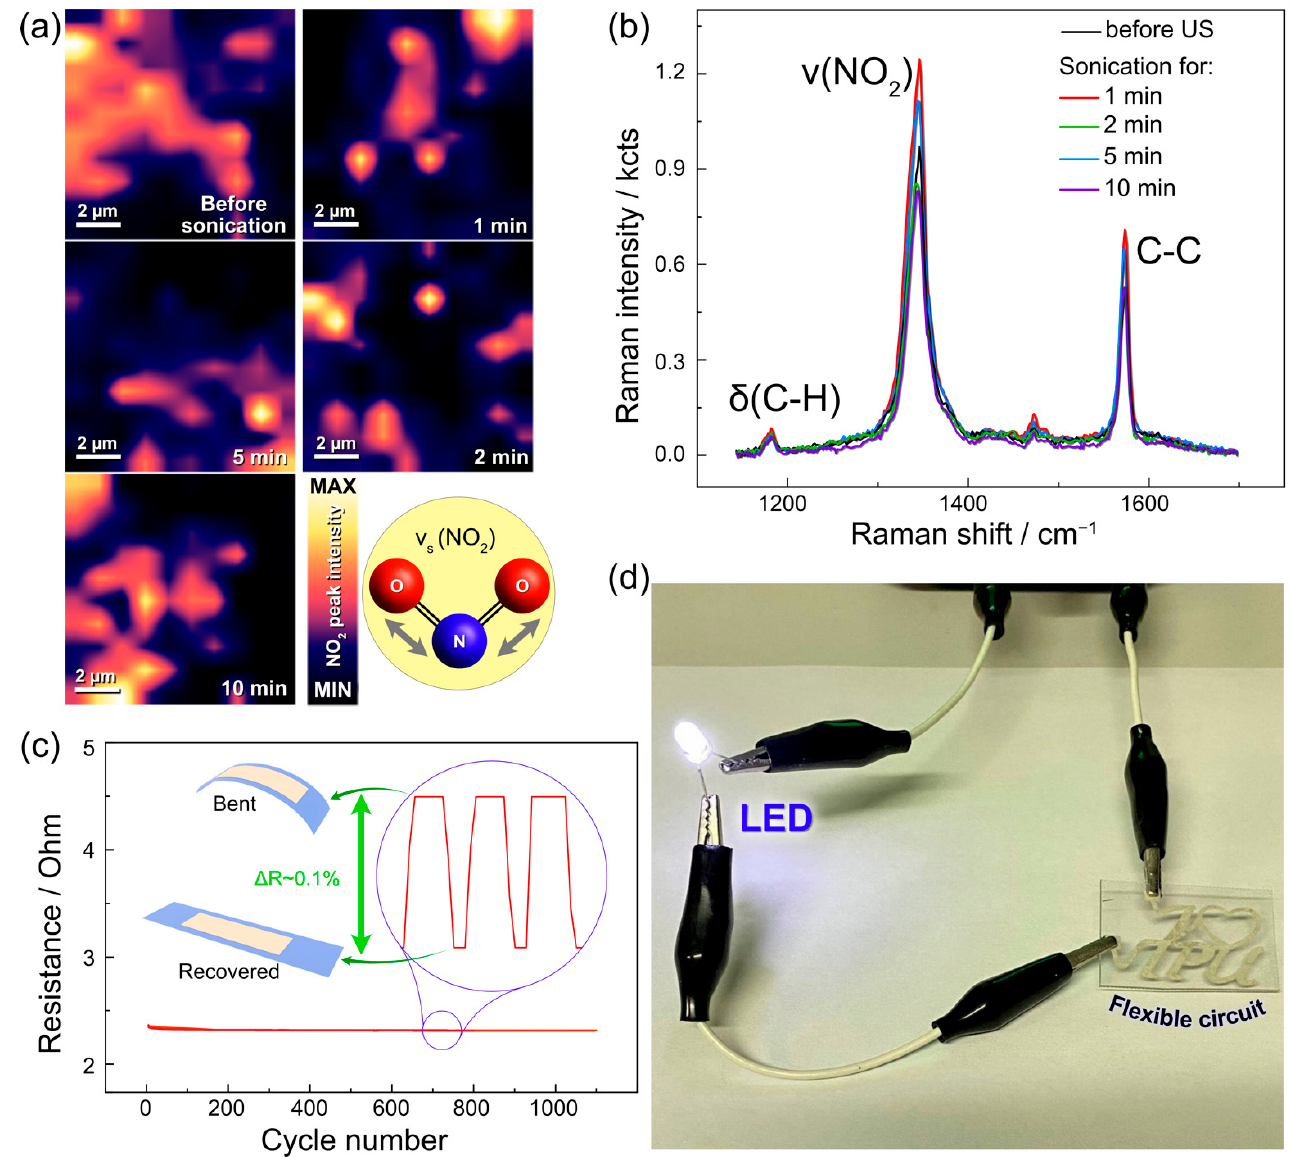
Figure 2. ( a ) The study of reusability and robustness by placing the substrate into the ultrasonic bath for different time periods: 0, 1, 2, 5, and 10 min. The performance was estimated with a Raman map of NO 2 vibrational mode. ( b ) Raman spectra of the sample after each ultrasound session in absolute scale. ( c ) Bending test of the AgLIMPc. ( d ) Demonstration of the ability to create a flexible circuit by powering LED through AgLIMPc sample.